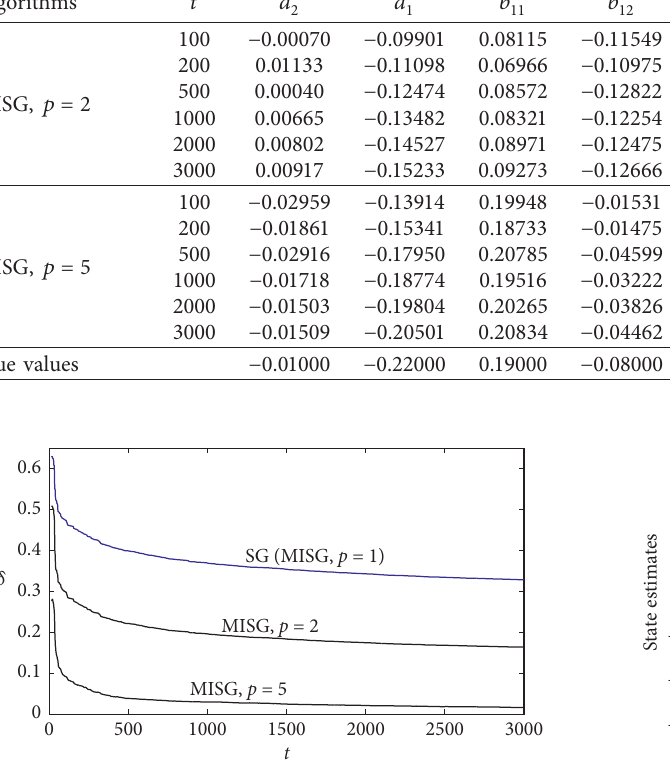
( t ) versus t ; solid line: the 1 ( t ) . 1